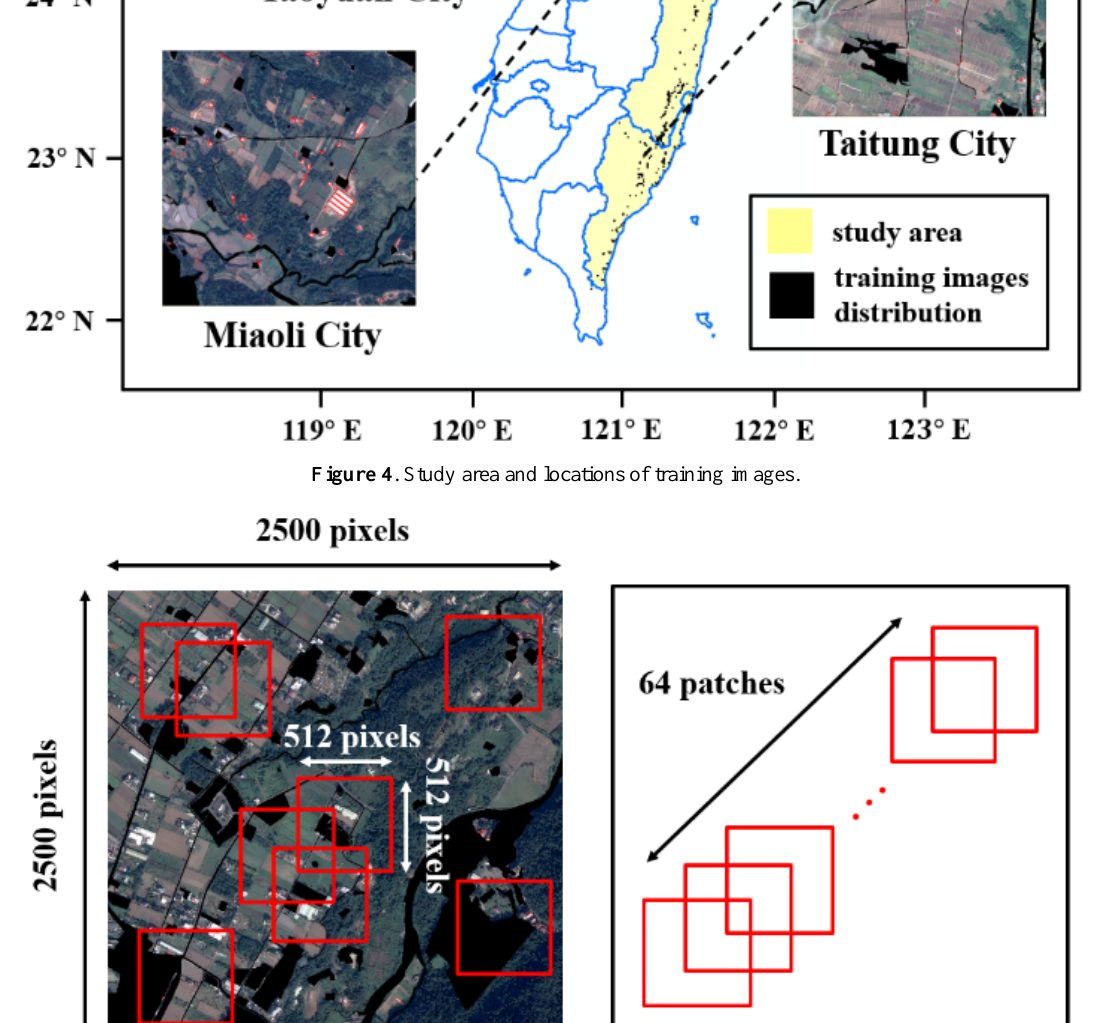
are defined as true positive (TP) and true negative (TN); incorrectly predicted building and non-building pixels are defined as false negative (FN) and false positive